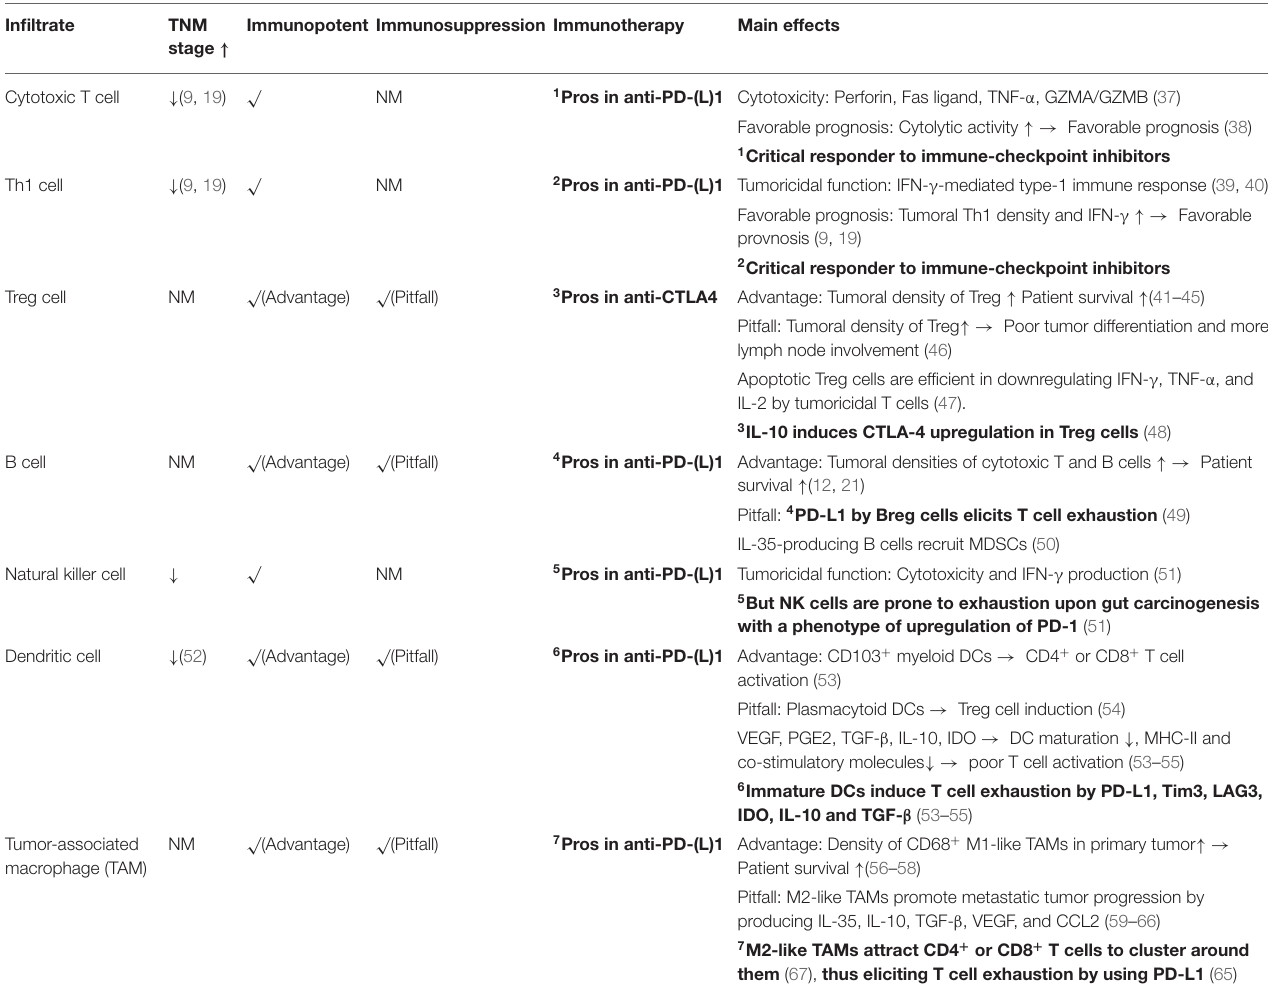
TABLE 2 | Immune infiltrate-dedicated tumoral microenvironment and CRC immunotherapy.